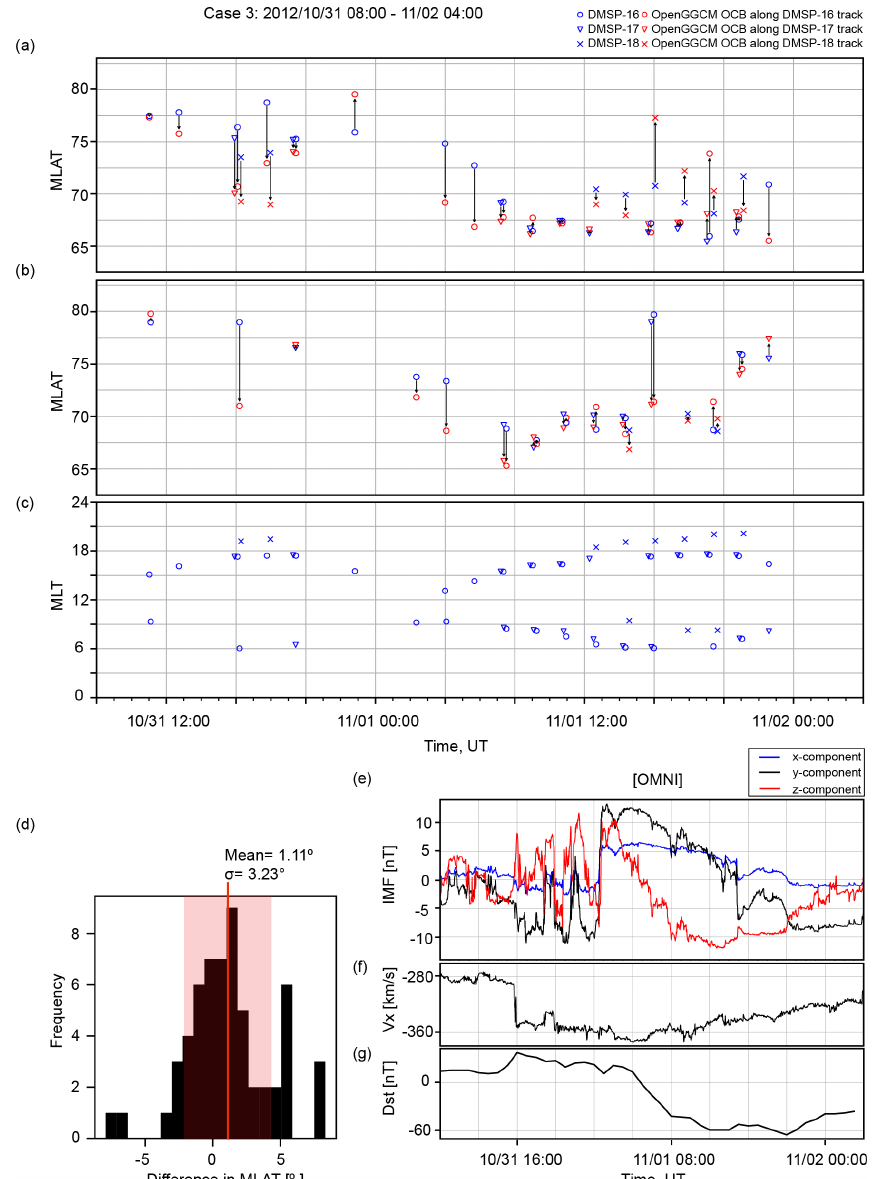
Figure 3. Comparison between the observed and simulated OCB latitudes for 1 November 2012 event in the same format as Fig.